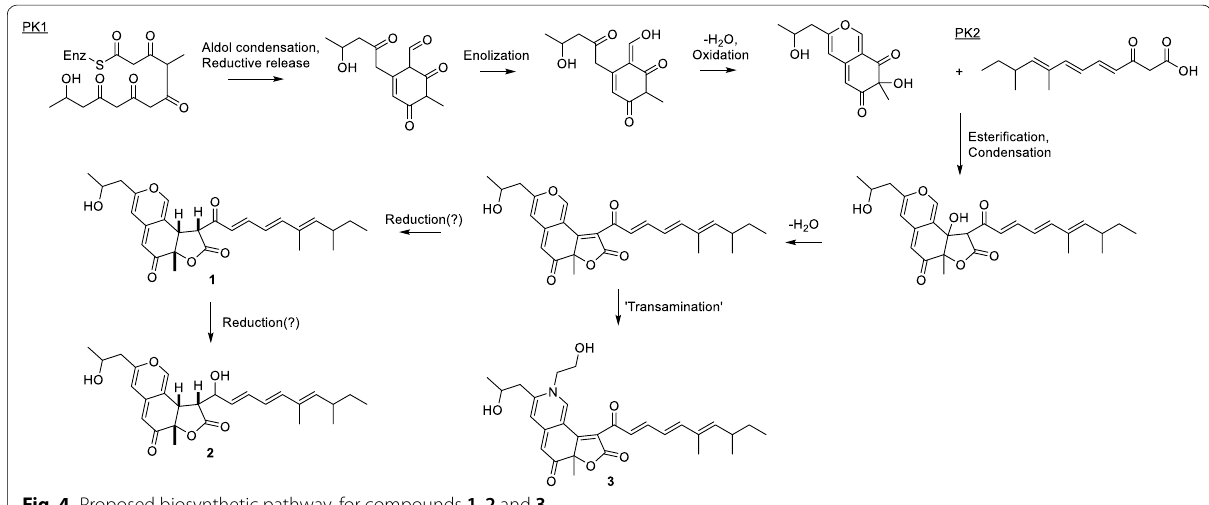
Fig. 4 Proposed biosynthetic pathway, for compounds 1 , 2 and